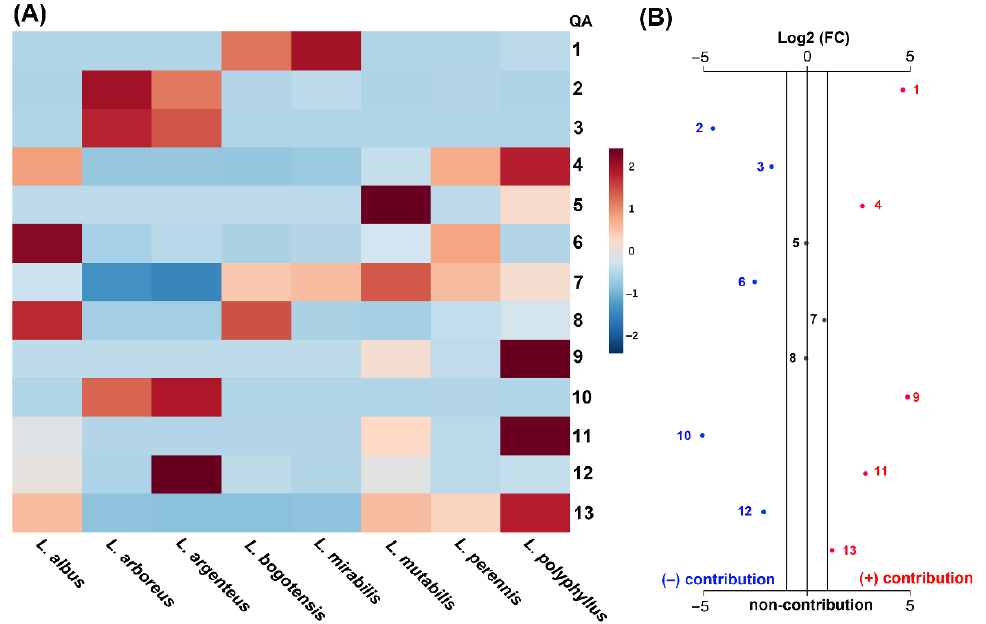
Figure 4. Comparison of QA contents (mg/g fresh leaves) among QREs obtained from leaves of eight lupin species. ( A ) Heatmap visualization of the normalized content distribution (unit of variance scaling) of QAs 1 – 13 from test lupins. Autoscaled QA contents are related to the color scale: 2 = high content; − 2 = low content. ( B ) Unpaired fold-change (FC) analysis plot for selecting important QAs with threshold 2, by integrating the chemical (QA contents) and biological (mycelial growth inhibition) data. Antifungal activity was used as a categorical variable, subdividing the antifungal activity of QREs into two datasets: more active (>80% inhibition) and less active (<75% inhibition), according to the Tukey test, to supervise the QA selection. According to the antifungal activity, positive and negative contributions to the FC-based QA selection are depicted as red and blue numbers and dots.